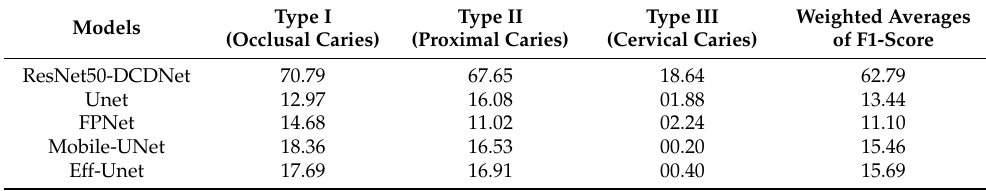
Table 5. F1-Score Performance comparison of DCDNet and other